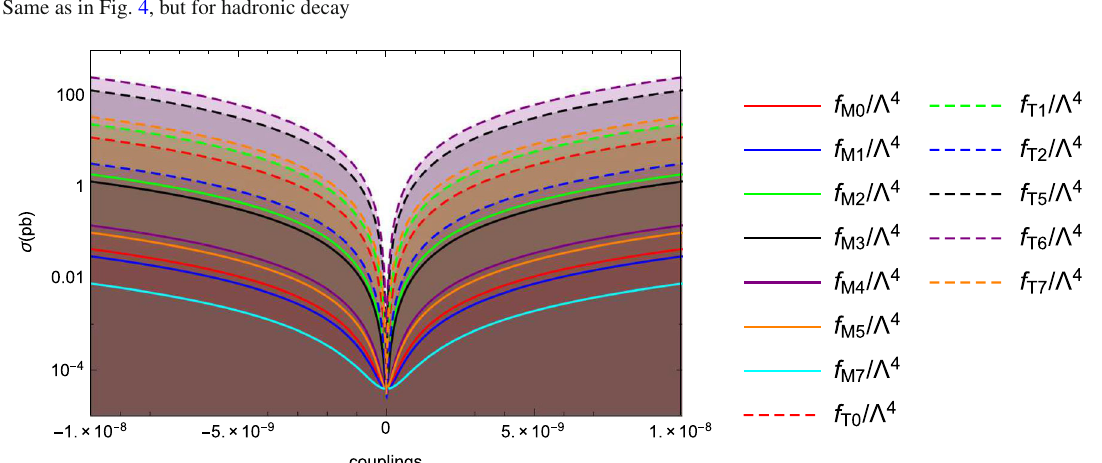
√ s = 5 . 29 TeV at the